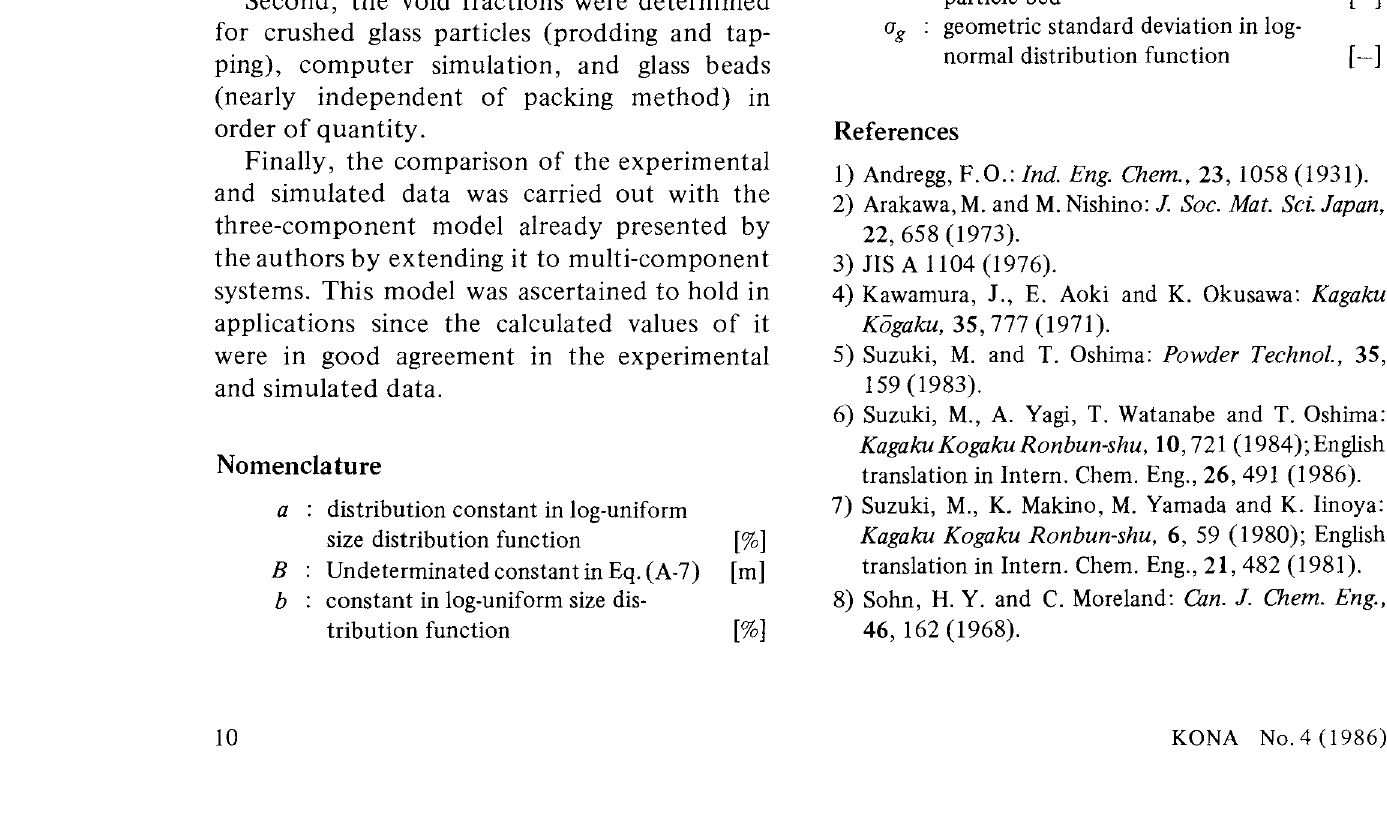
proportionality constant in Eq.(A-5)